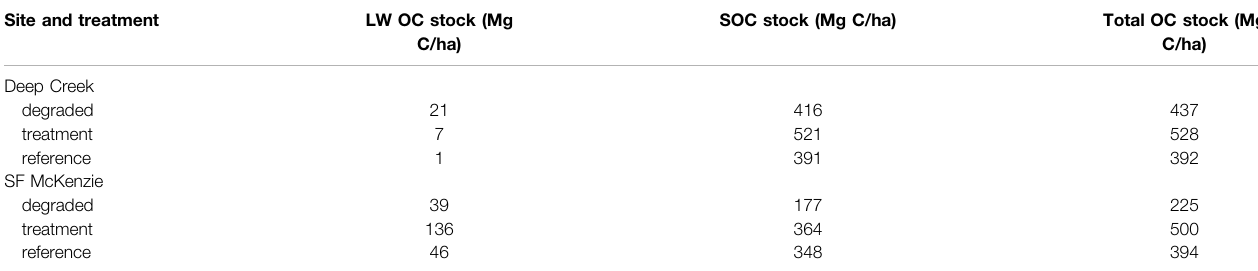
TABLE 3 | Estimated carbon stocks in large wood and soil at the case study